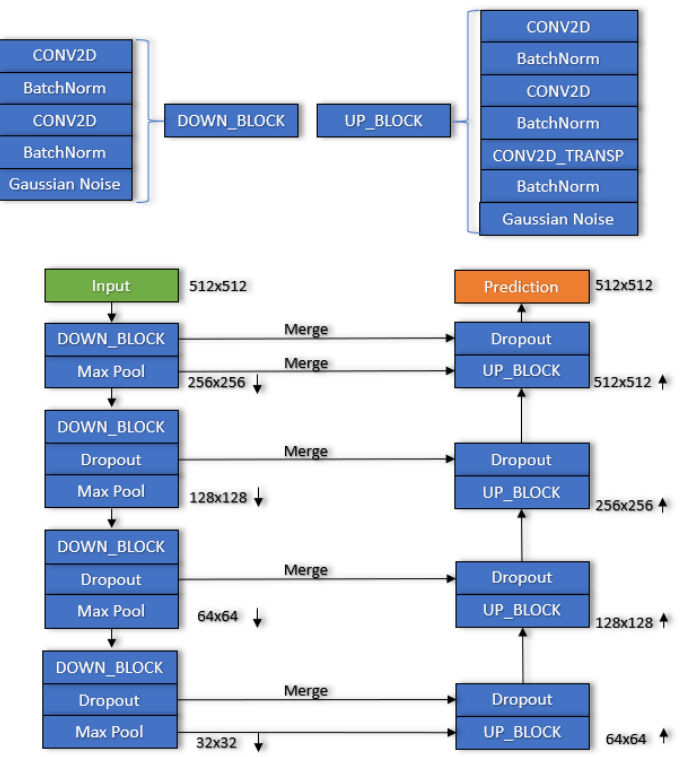
Figure 2. A diagram of the network architecture used in this study. Down-sampling and up-sampling convolutional blocks are defined independently. Input data travel through a combination of down- sampling blocks, dropout, and pooling layers. The final down-sampled output is then passed through a combination of up-sampling blocks, dropout, and merge layers to create a final prediction of bathymetry. Figure from